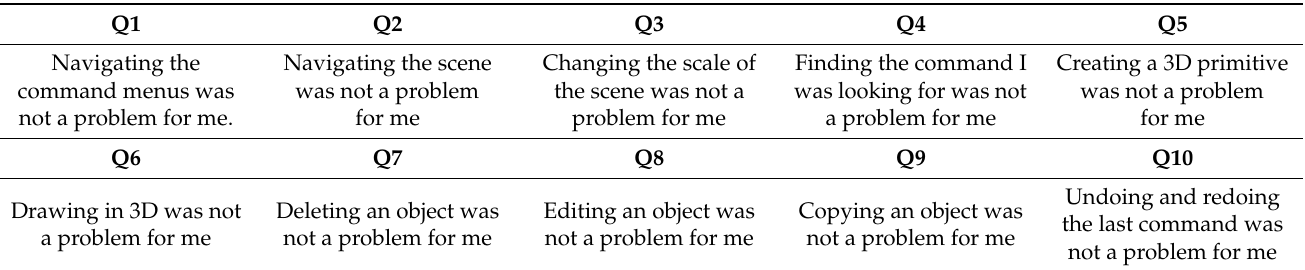
Table 7. Ease of use questionnaire